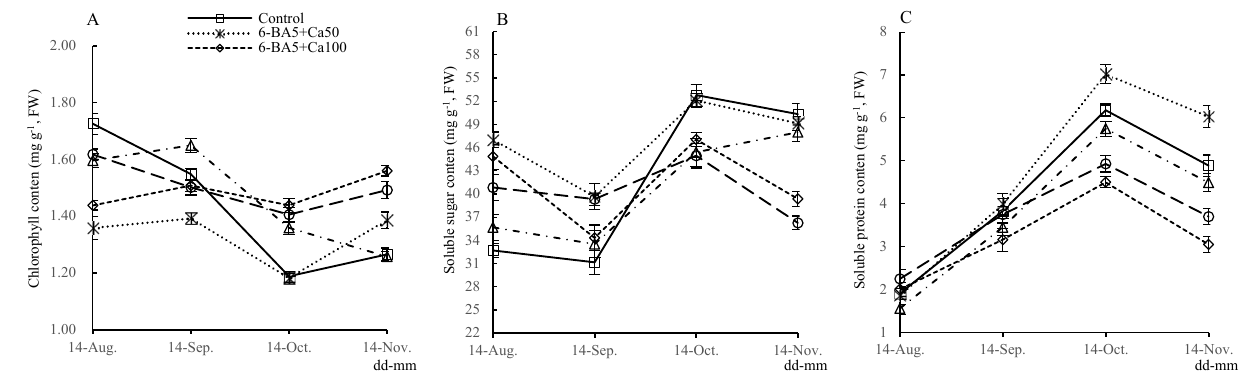
Figure 1. Changes of leaf physiological index of Hangbaiju. Chlorophyll content ( A ), soluble sugar content ( B ) and soluble protein content ( C ). Control: water + decapitation; 6-BA 5 + Ca 50 : 5 mg/L 6-BA + 50 mg/L Pro-Ca; 6-BA 5 + Ca 100 : 5 mg/L 6-BA + 100 mg/L Pro-Ca. The error bars represent the standard error of the mean (n = 5).